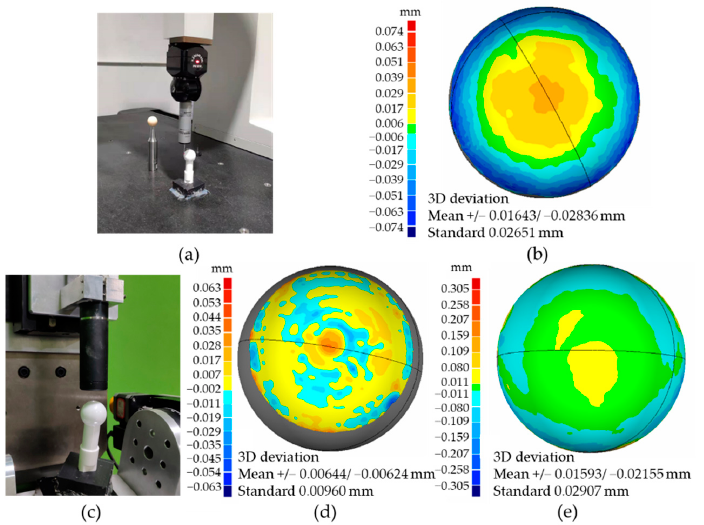
Figure 13. Comparation of results: ( a ) the measure process on the CMM; ( b ) measurement results (50% spherical surface) by the CMM; ( c ) the measure process on our five-axis system; ( d ) results of the same measured area (25% spherical surface) by the five-axis system; ( e ) measurement results of 70% of the spherical surface by the five-axis